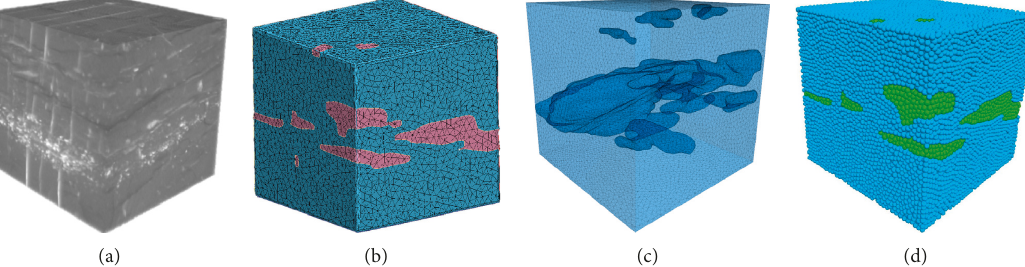
Figure 13: 3D DE model generate of HCR. This figure presents (a) the raw coal sample; (b) the smoothed surface model; (c) the simplified surface model; and (d) the 3D DE model of HCR.